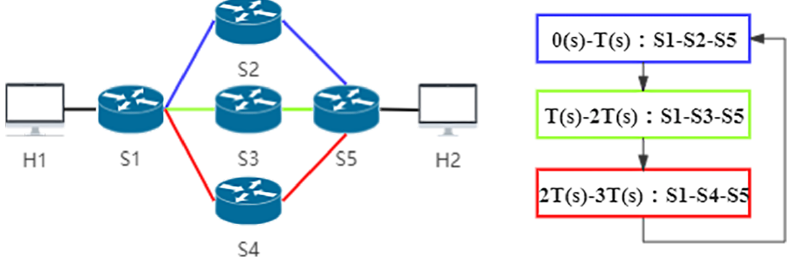
Fig. 4 The process of dynamically changing forwarding path rules.